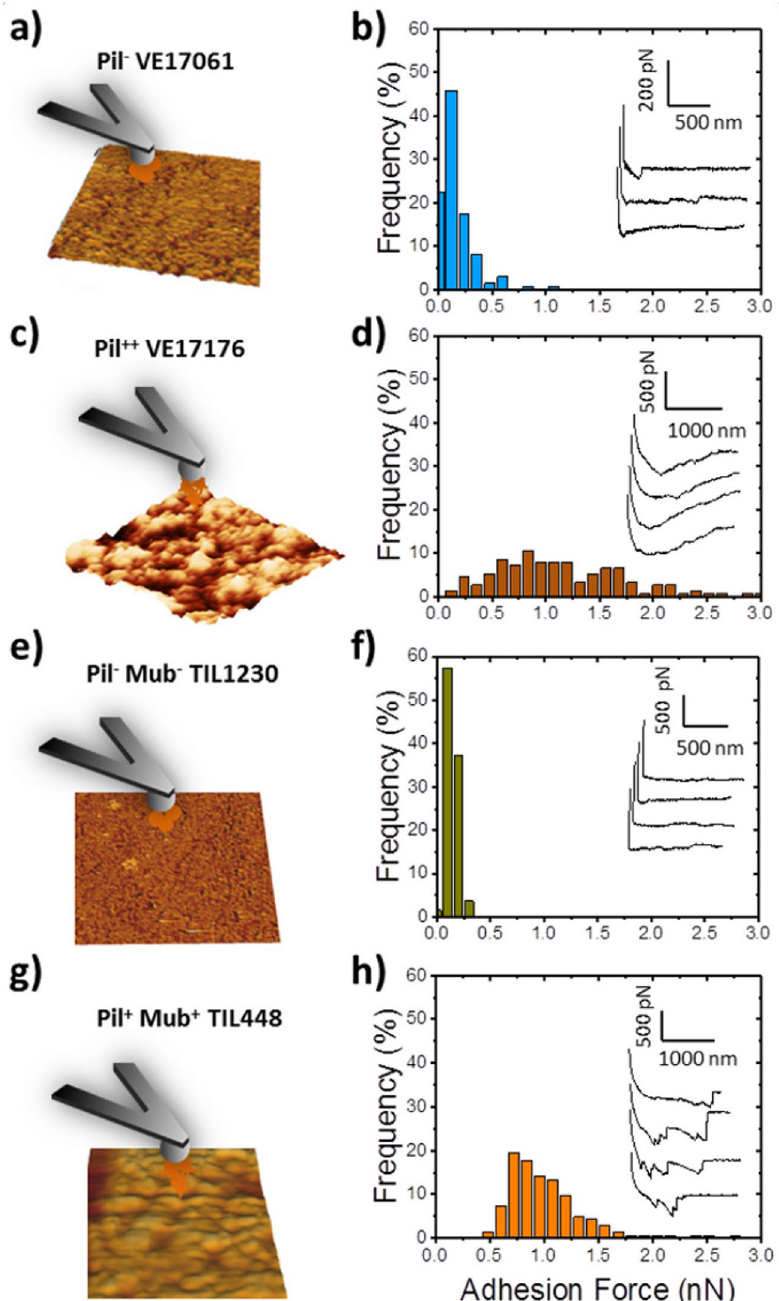
Figure 5. Quantification of the interactions between individual cells and 24 h-biofilms of L. lactis . ( a , c , e , g ) show measurement methods. ( b , d , f , h ) Adhesion force histograms and typical force curves obtained by recording force curves on 50 µm × 50 µm biofilm surface with 16 × 16 pixels in Pil − VE17061 ( b ), Pil ++ VE17176 ( d ), Pil − Mub − TIL1230 ( f ), and Pil + Mub + TIL448 ( h )